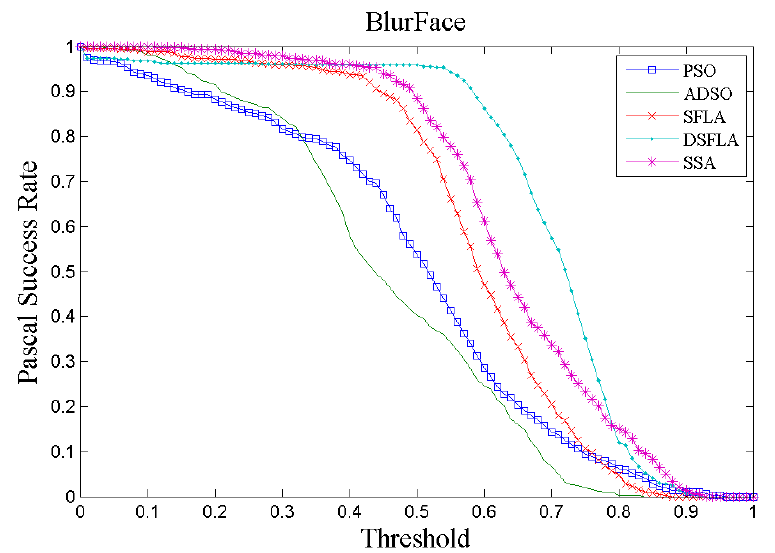
Figure 4. The success rate curve per Pascal metric of video 4 (BlurFace) for all trackers.